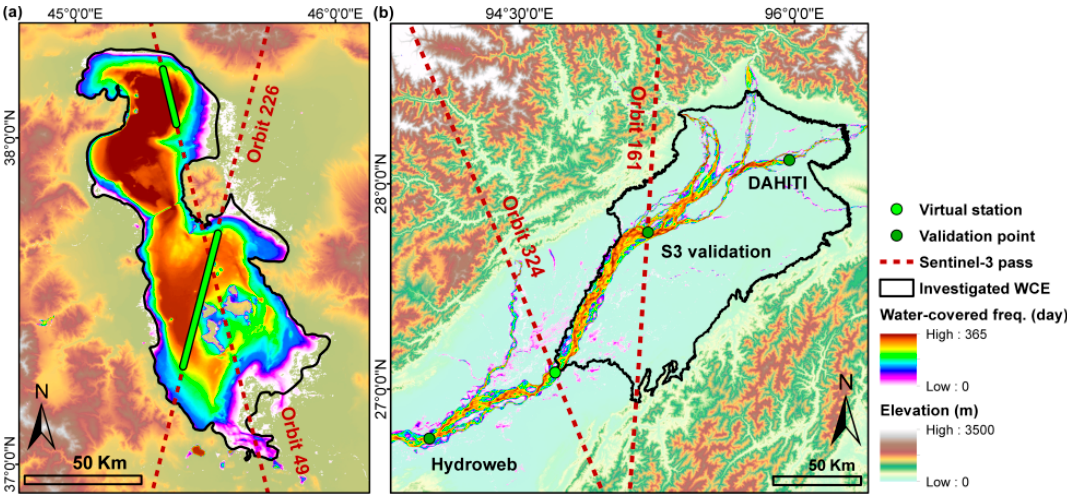
Figure 1. The locations of the study areas with the Sentinel-3 altimetry satellite pass ground tracks (dotted red lines) and the corresponding virtual stations (VSs) (green points). The investigated water-covered extent (WCE) (black polygon) and the average water-covered frequency of 2003–2018 derived from the Global WaterPack (GWP) are illustrated for ( a ) Lake Urmia and ( b ) Brahmaputra